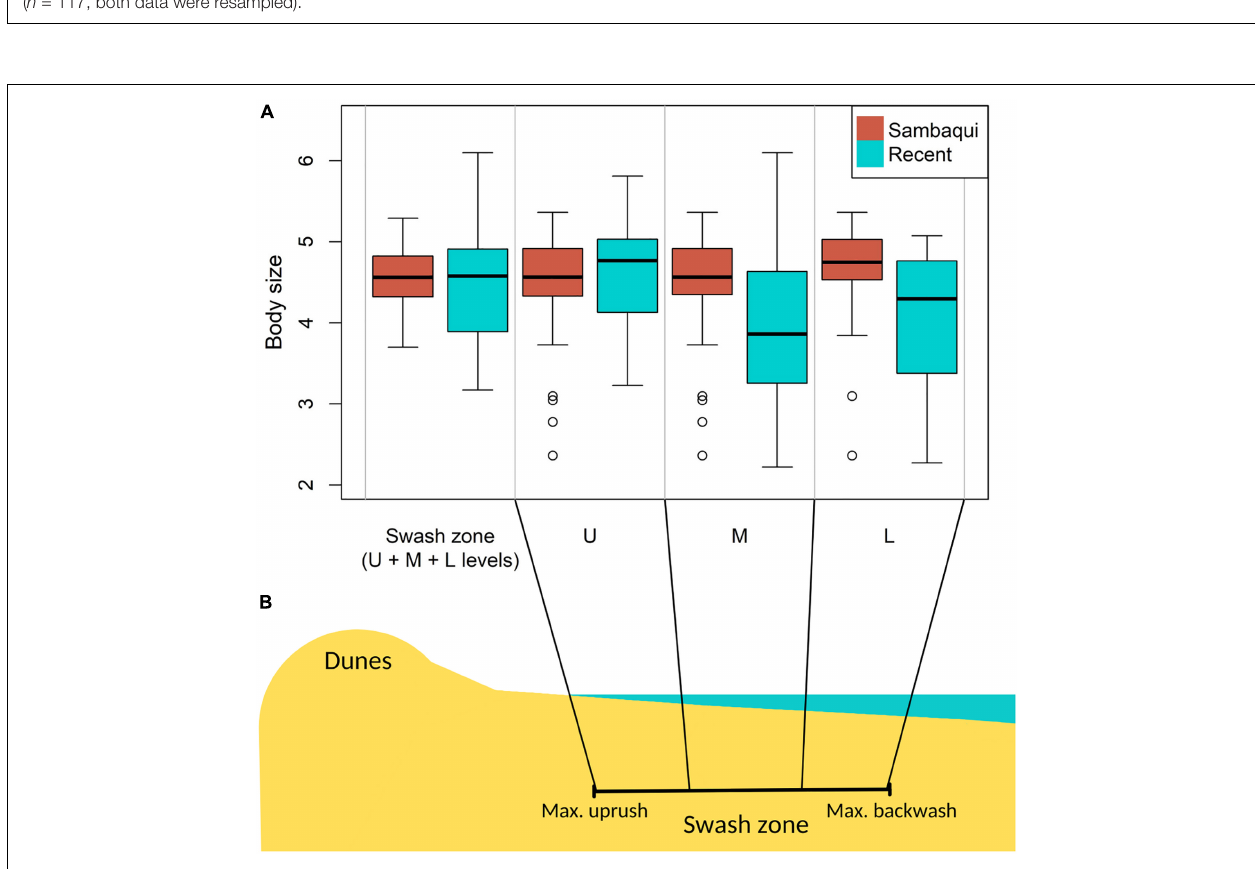
FIGURE 4 | Box plot of comparison between valves body sizes from all levels of the swash zone (upper: U, middle: M, and lower: L) of the transect Altair shipwreck–Sarita Lighthouse and valves from sambaquis ( n = 74, sambaqui data were resampled), valves from the upper level of the swash zone and ancient valves ( n = 31, sambaqui data were resampled), middle-level swash zone and ancient valves ( n = 30, sambaqui data were resampled), and valves from the lower level of the swash zone and sambaqui valves ( n = 13, sambaqui data were resampled) (A) ; and location of the upper, middle and lower levels within swash zone (B) .